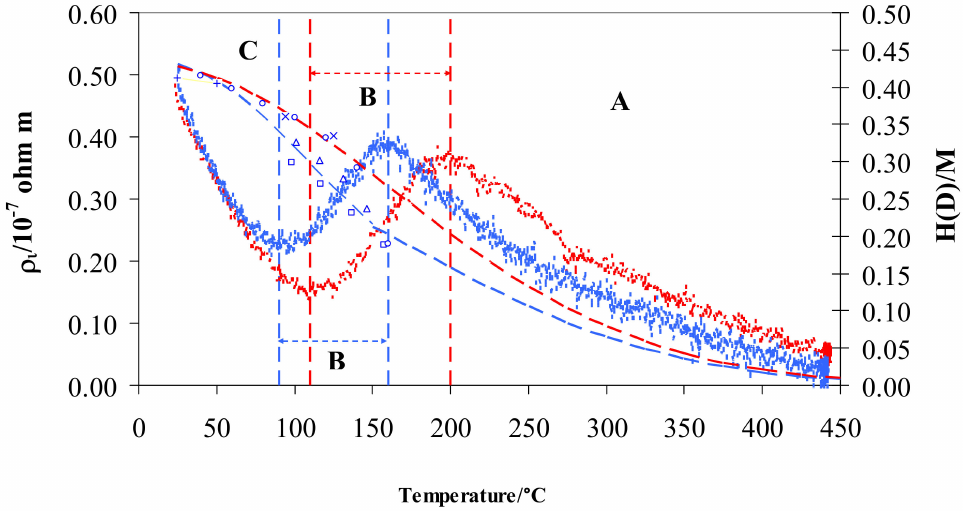
Figure 4. ρ i vs. temperature for Pd-Ag 21 wt.% in pure hydrogen (red) and deuterium (blue) and relative H / M (red) and D / M (blue) values at 100 kPa. The literature data for D / M: ( + ) [18], ( × [22], ( (cid:52) ) [23], ( (cid:3) ) [45] are also shown. Vertical dashed lines show the limits for the di ff erent regions A, B, and C in pure hydrogen (red) and deuterium